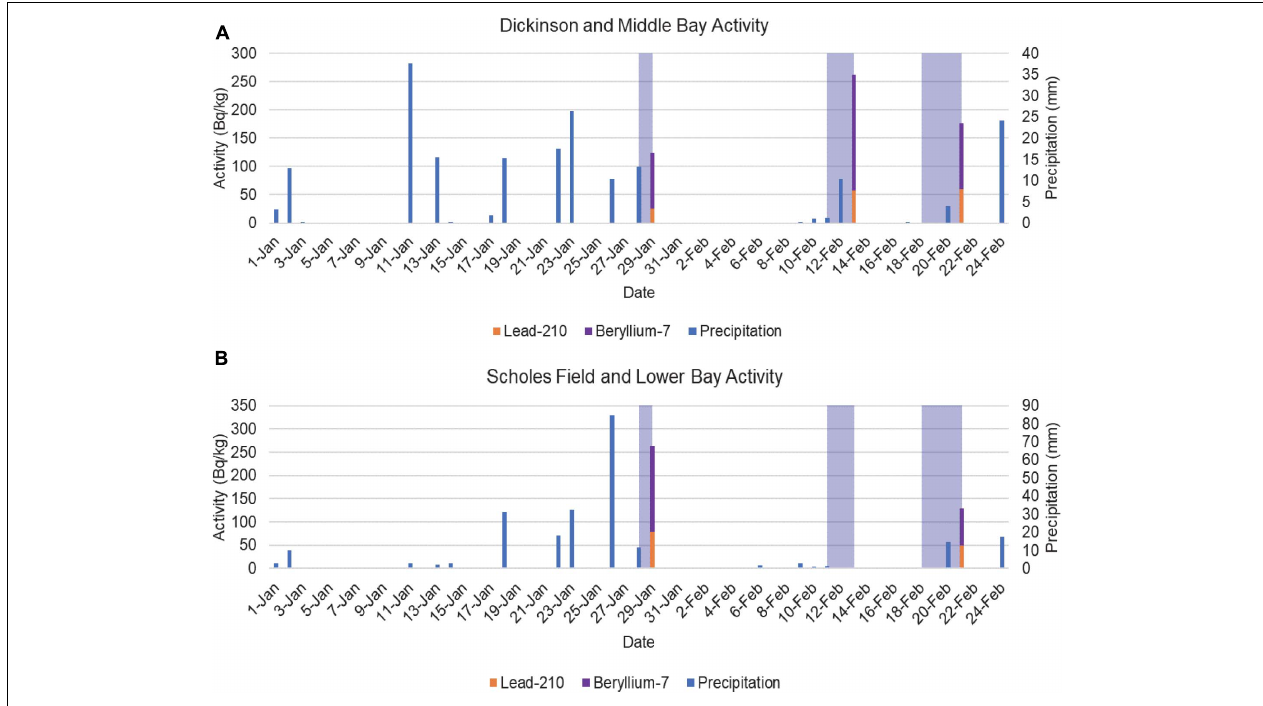
FIGURE 2 | Rainfall vs. Isotope Activity. Rainfall data (blue) from Dickinson (A) and Scholes Field (B) Station (NWS) and Isotopic Activity of 210 Pb (orange) and 7 Be (purple) collected at the middle and lower bay site. Shading represents our precipitation sampling period.